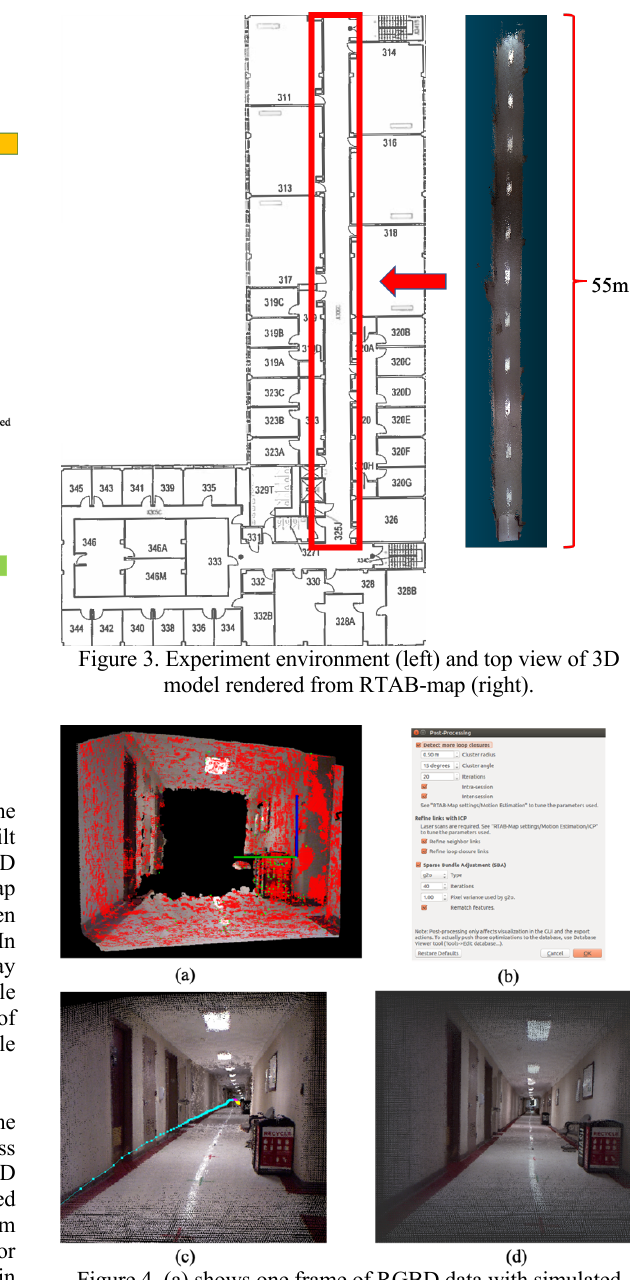
Figure 4. (a) shows one frame of RGBD data with simulated Lidar point cloud (red points). (b) is the screen shot of post processing with ICP selection in RTAB-map. (c) shows post processed 3D model with only RGBD data. (d) shows post processed 3D model with both RGBD and simulated Lidar data.